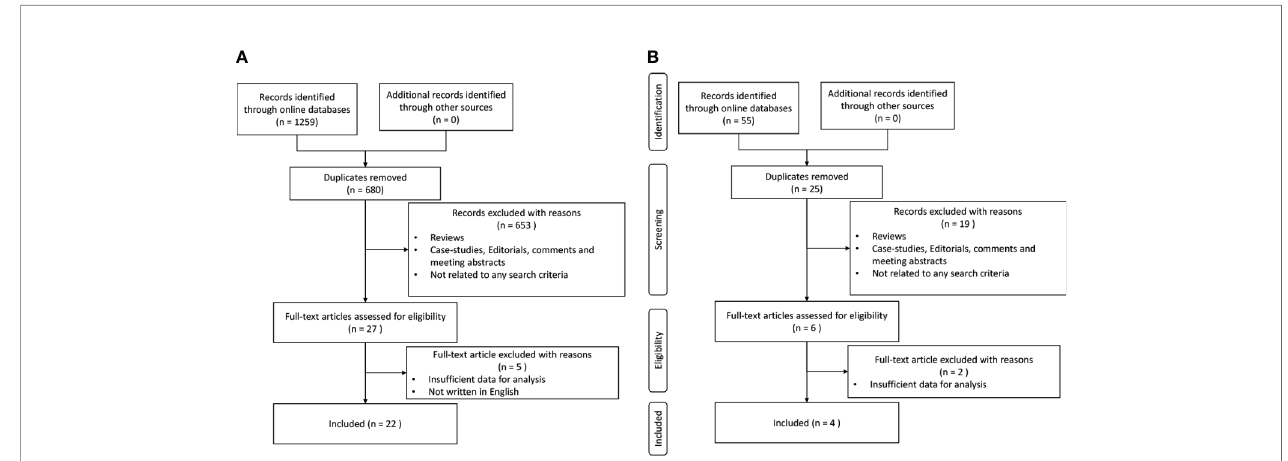
FIGURE 1 | Process of study selection. (A) Study selection with genetic alterations. (B) Study selection with PD-L1